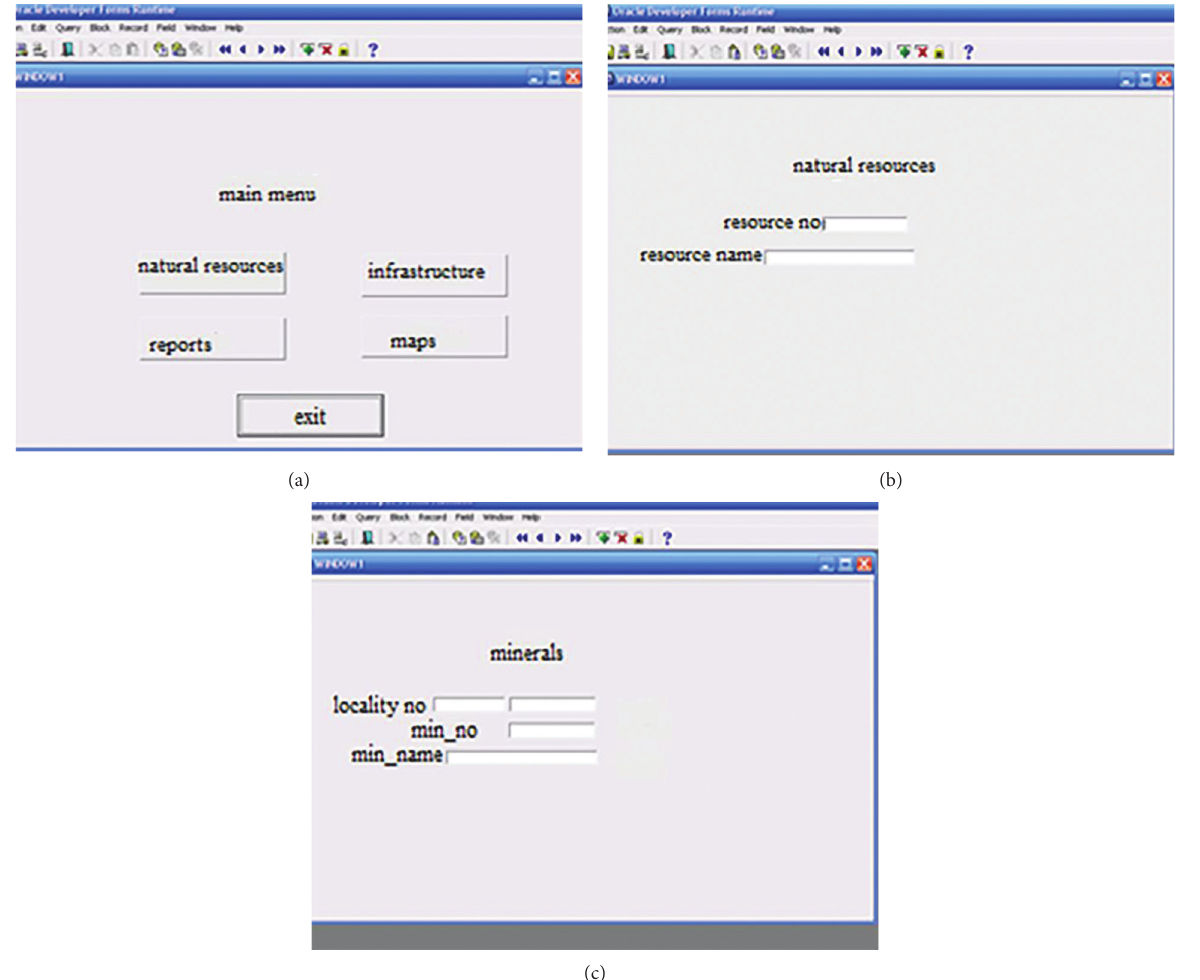
Figure 6: The system web-based interface. (a) Main screen. (b) Natural resources data entry. (c) Mineral recourses data entry